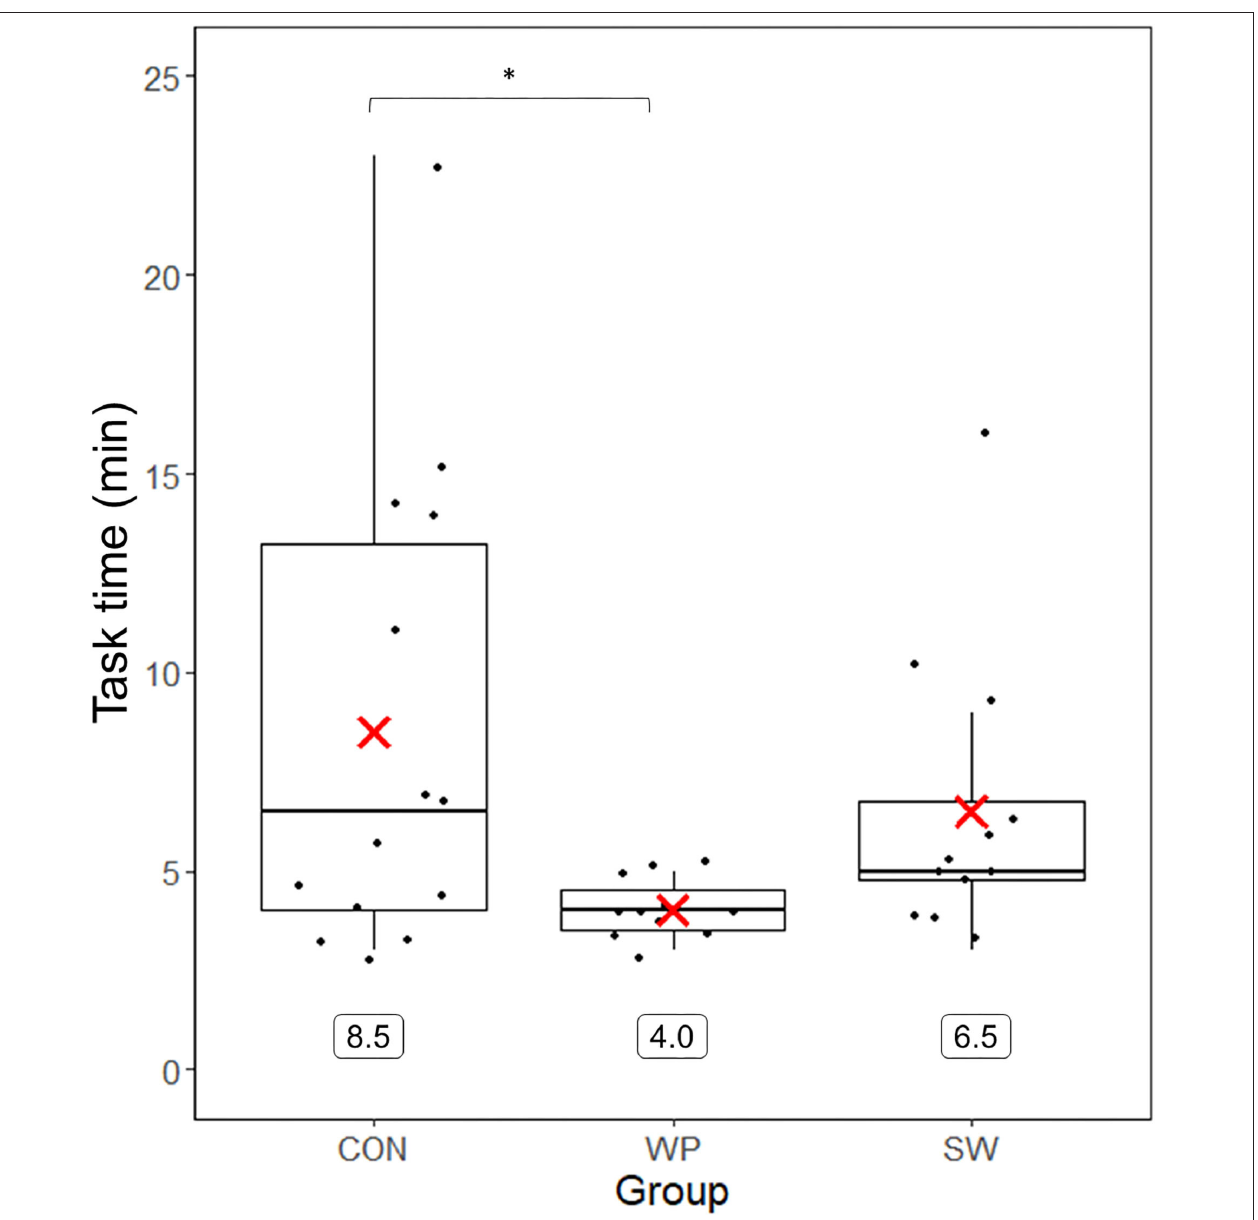
FIGURE 3 | Duration of the fatigue protocol for water polo athletes (WP), swimmers (SW), and a control group (CON). Group means are represented by the red X and displayed numerically below the boxplot. *Significant group difference between CON and WP.